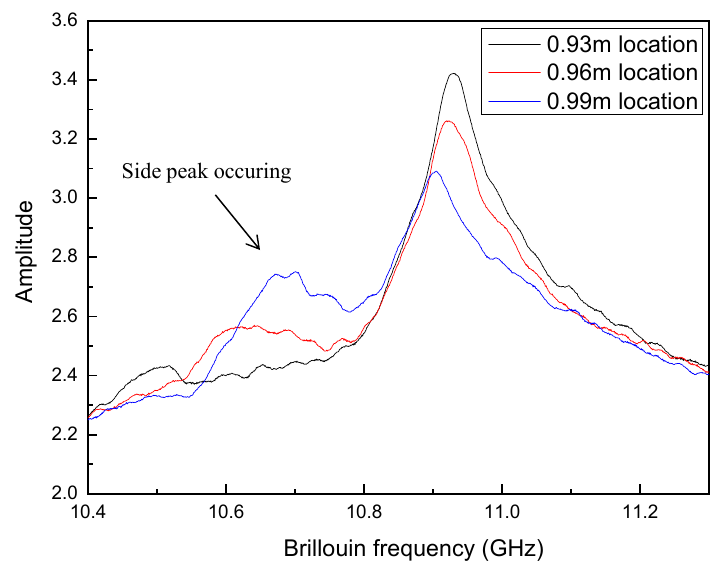
Figure 11. Brillouin spectrum of the optical fiber where the left side beam meets the crossbeam.